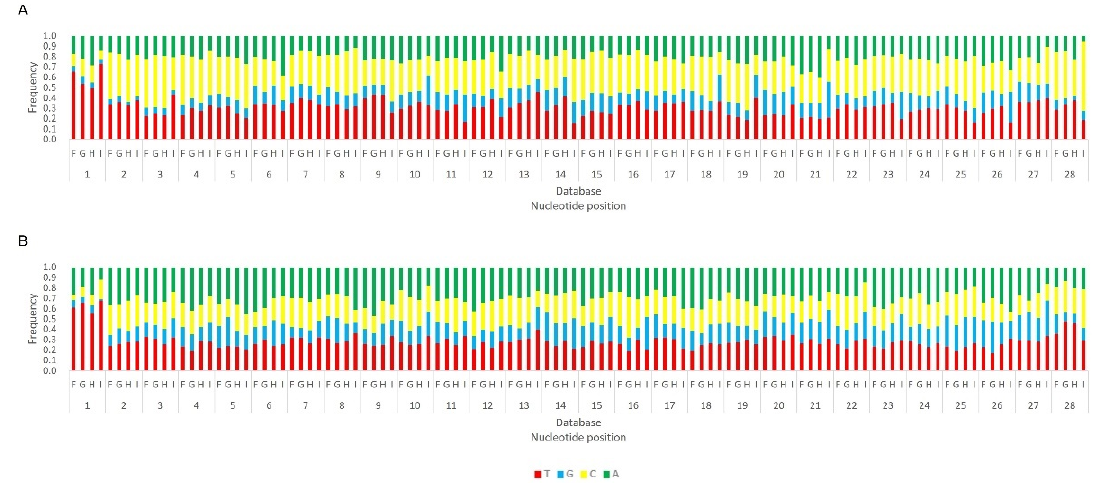
Figure 12. Relative nucleotide frequency of BmN4 Siwi-bound sense 28 nt-long sRNAs, mapped to the genome of B. mori Macula-like Latent Virus (MLV) ( A ) and S. frugiperda Rhabdovirus (RV) ( B ), databases F–I (Table S2). The Y -axis represents the relative nucleotide frequency. The X -axis represents the position in the read. T: thymine; G: guanine; C: cytosine; A: adenine. Since the sequenced reads correspond to cDNA, thymine corresponds to uracil in the original RNA molecule.